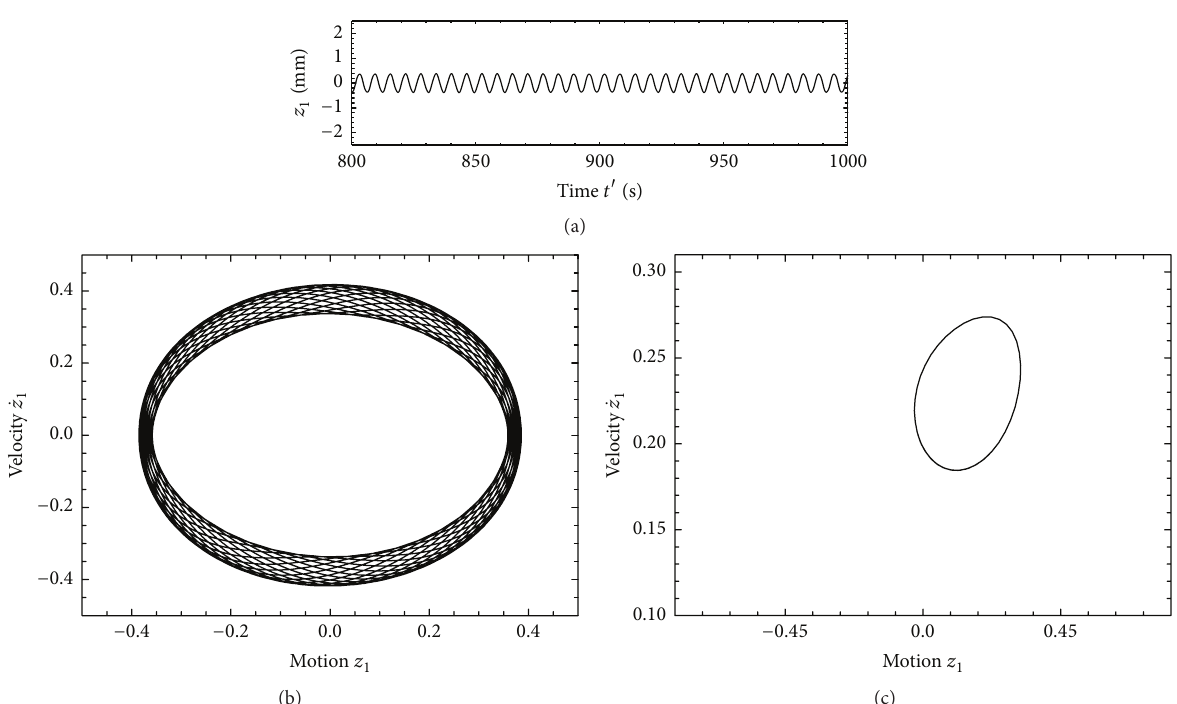
Figure 10: The time series and phase diagram when 𝜏 = 2 and 𝜔 = 154 rad/s: (a) time series; (b) the phase diagram; (c) the Poincare mapping section.